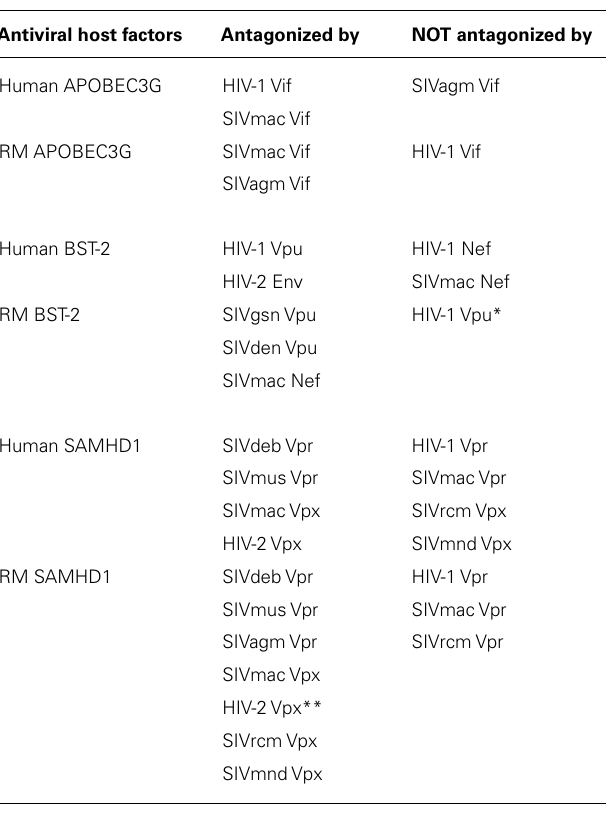
Table 2 | Species-specific restriction of lentiviruses by primateTRIM5 proteins.